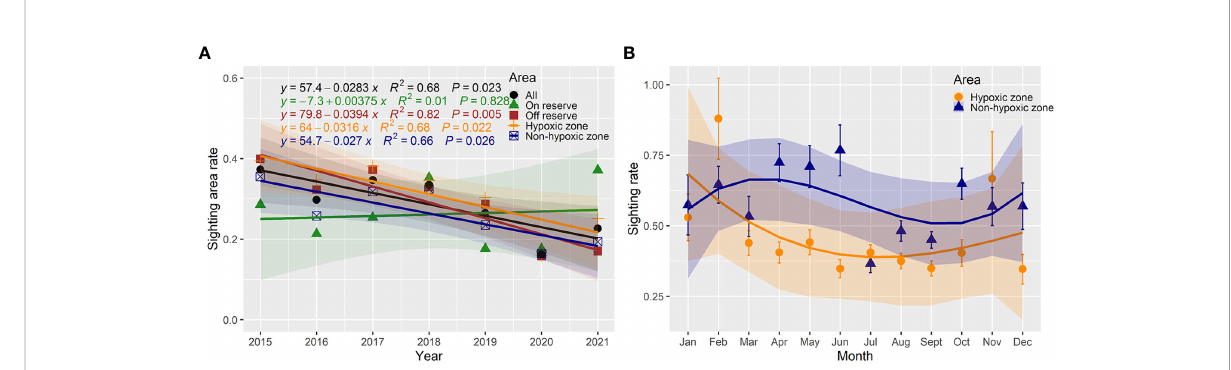
FIGURE 5 Variations of sighting area rates (annual sighting area/annual survey area) and sighting rates (sightings/surveys/km 2 ) of Indo-Paci fi c humpback dolphins in the Pearl River Estuary. (A) Linear correlation fi tting of sighting area rates with year in different areas from 2015 to 2021. (B) Variations of monthly mean dolphin sighting rates in the hypoxic and non-hypoxic